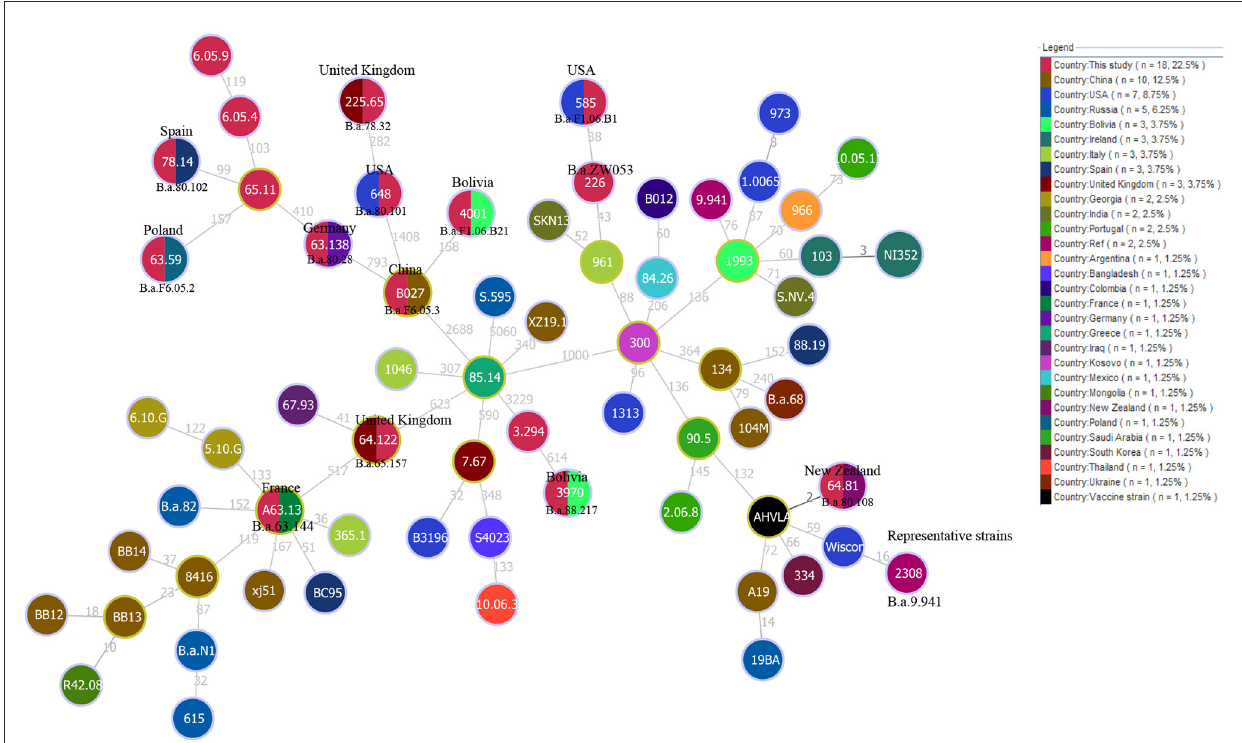
FIGURE7 WGS-SNP phylogeny analysis of B. abortus strains from the present study and worldwide strains based on the SNP matrix of 80 B. abortus . Strains code are marked in black if they share the same SNP genotype with the strain in the circle. The countries marked in the figures indicate that strains from this country have identical SNP genotypes with strains from the present